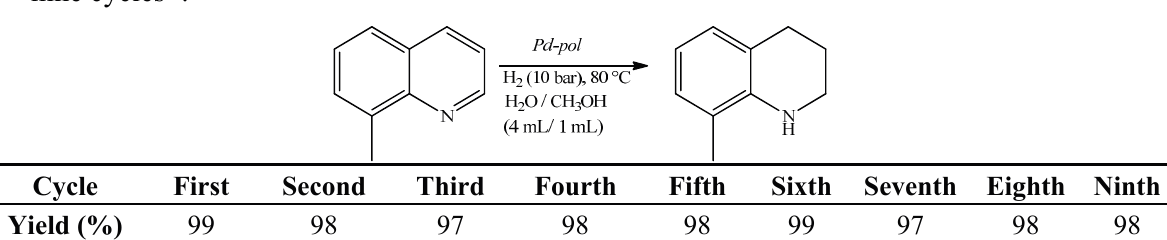
Table 3. Hydrogenation of 8-methylquinoline to 8-methyl-1,2,3,4-tetrahydroquinoline over nine cycles a .